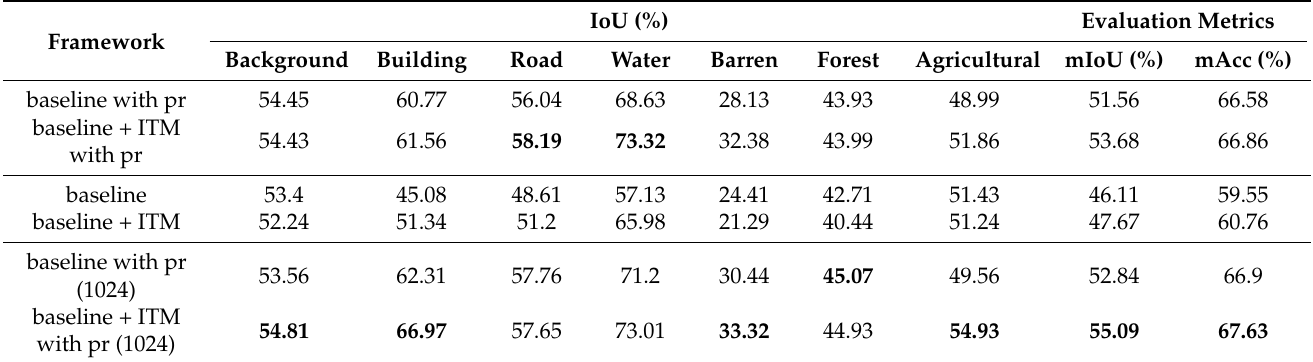
Table 2. Ablation analysis of input transform module on the LoveDA dataset. The maximum value of each column is shown in bold.